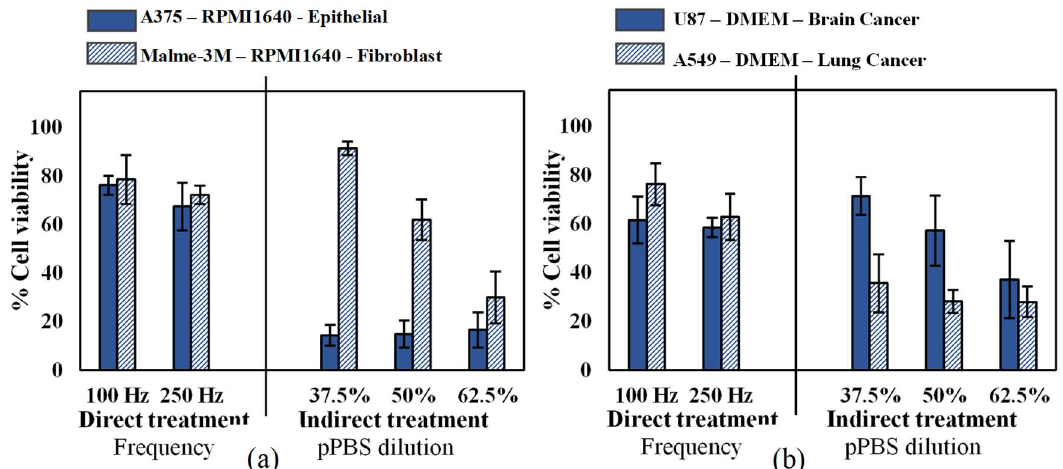
Figure 1. Analysis of the influence of the cell type and cancer type on both direct treatment (FE-DBD at two different frequencies) and indirect treatment (pPBS in three different dilutions). ( a ) Comparison of an epithelial cell line (A375) with a fibroblast cell line (Malme-3M), which are both skin cancer cell lines. ( b ) Comparison of a brain cancer cell line (U87) with a lung cancer cell line (A549). For both figures, the cells were cultured in the same cell culture medium and treated with exactly the same conditions. Therefore, the only variables tested were ( a ) cell type and ( b ) cancer type. Data are represented as mean ± standard deviation (SD) of three independent experiments with at least two replicates. Statistical significance of all treatment conditions was compared to untreated. * p < 0.05, ** p < 0.01, and *** p < 0.005 (one-way ANOVA).